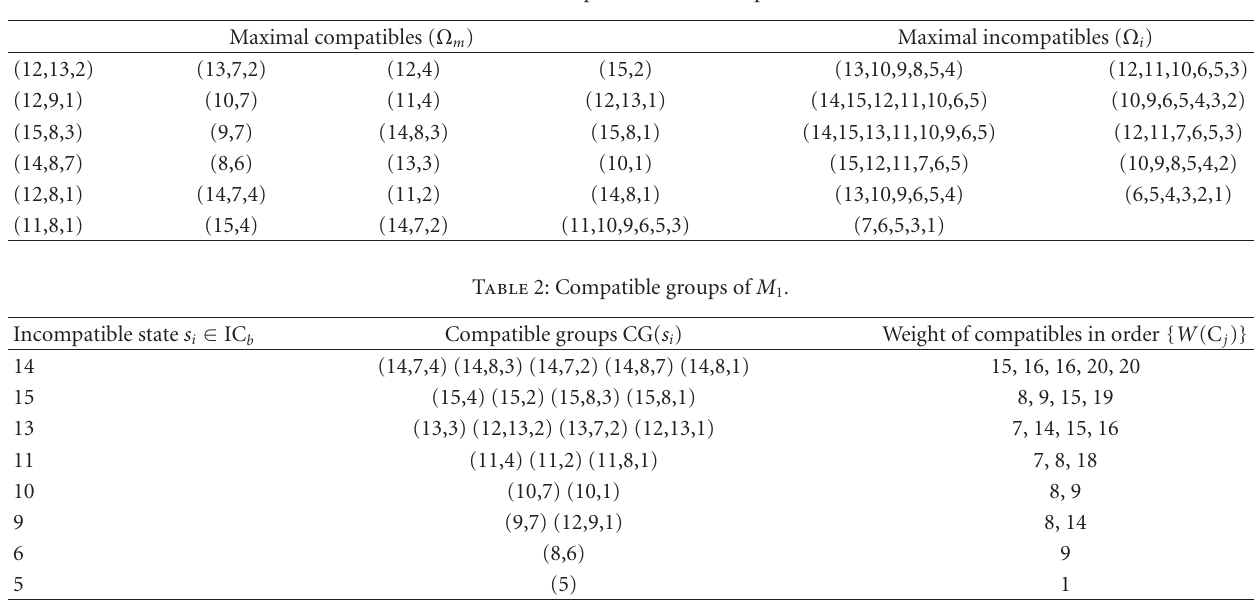
Table 1: Maximal compatibles and incompatibles of M 1 .